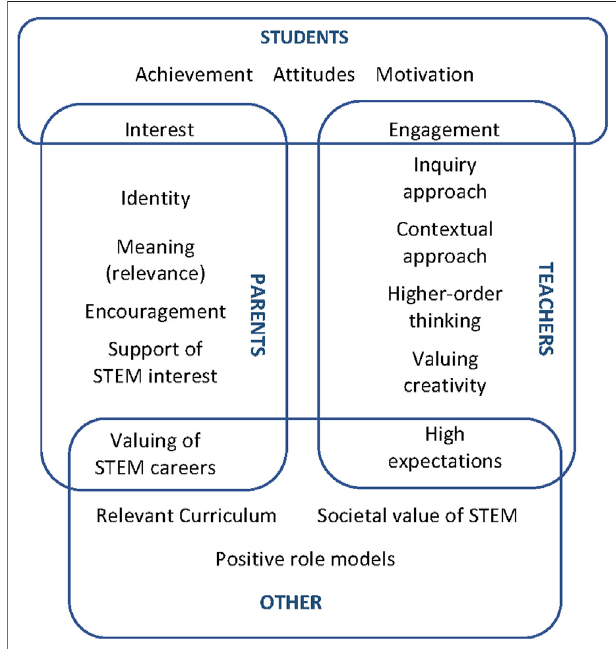
FIGURE 1 | Major factors impacting student choice of STEM subjects and careers(adaptedfromPanizzonandWest fi eld,2009ascited inClarkand Simon,